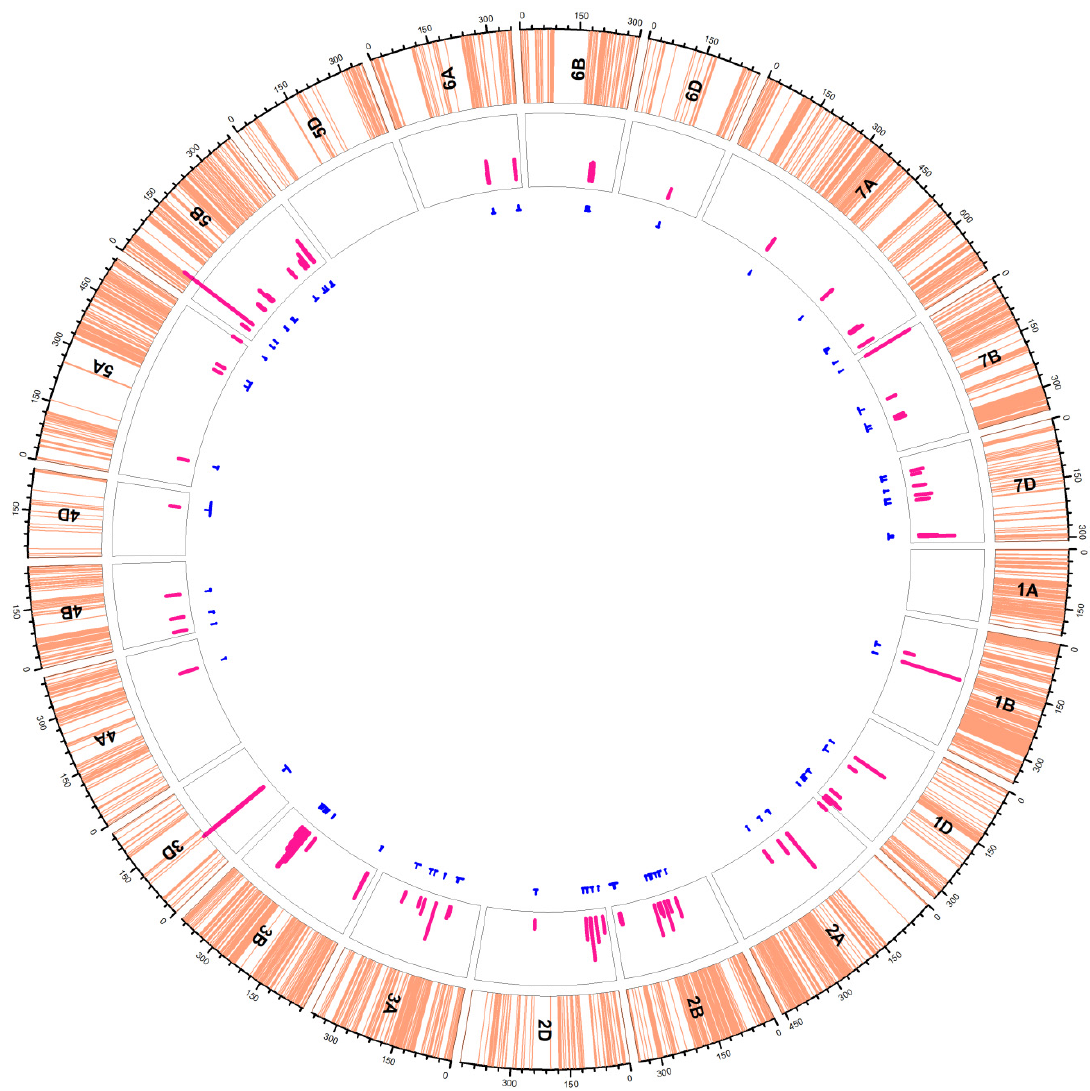
Figure 4. Distribution of additive QTLs (blue lines in the inner circle). Light orange lines in the outer track indicate the SNP positions on each chromosome. Pink bars in the second circle indicate the LOD values of QTLs. The blue lines under the track circle indicate the confidence interval of QTLs with small vertical lines pointing to the peak position of QTL. For details, see Table S1.